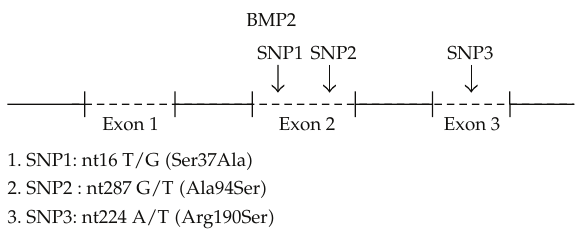
Figure 1: Schematic diagram of the three single nucleotide poly- morphisms in BMP2 gene.